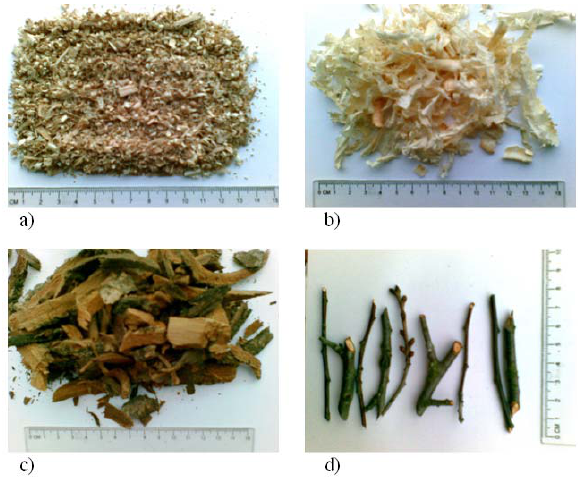
Fig. 2. Additional materials used for composting: a) oak saw- dust; b) aspen chips; c) crushed ash-tree bark, d) minor twigs of